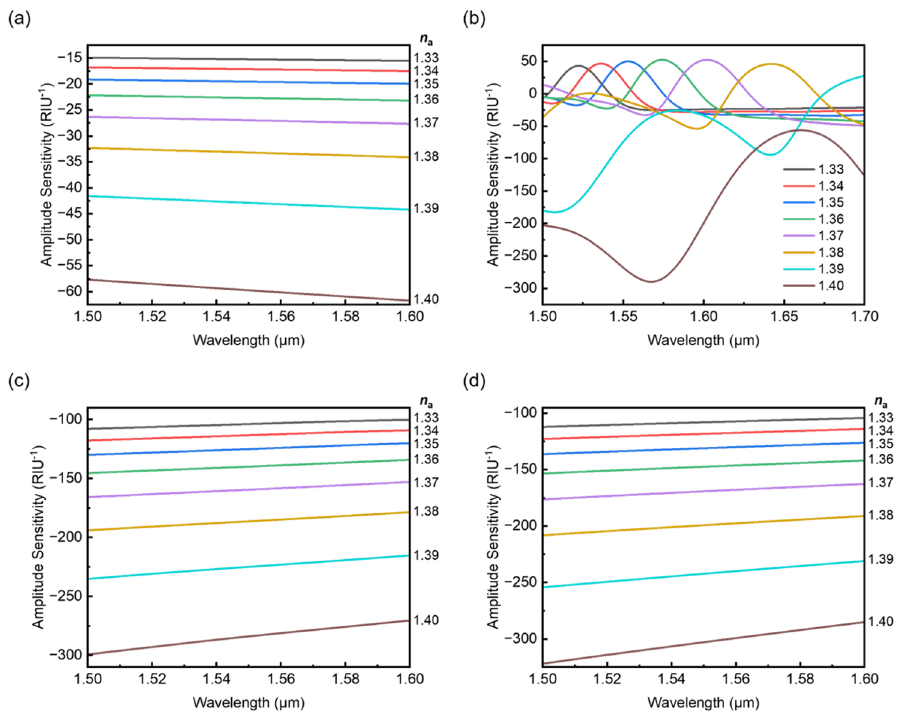
Figure 10. Amplitude sensitivity for selected twist rate A = 5 ( a ), 12.1 ( b ), 20 ( c ) and 25 cm − 1 ( d ).